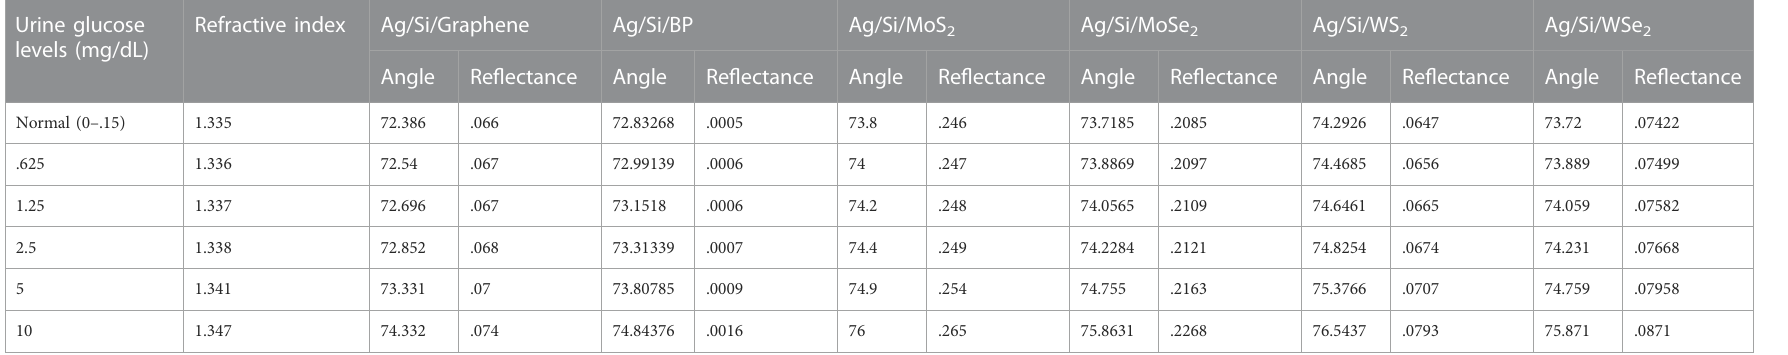
Angle Re fl ectance Angle Re fl ectance